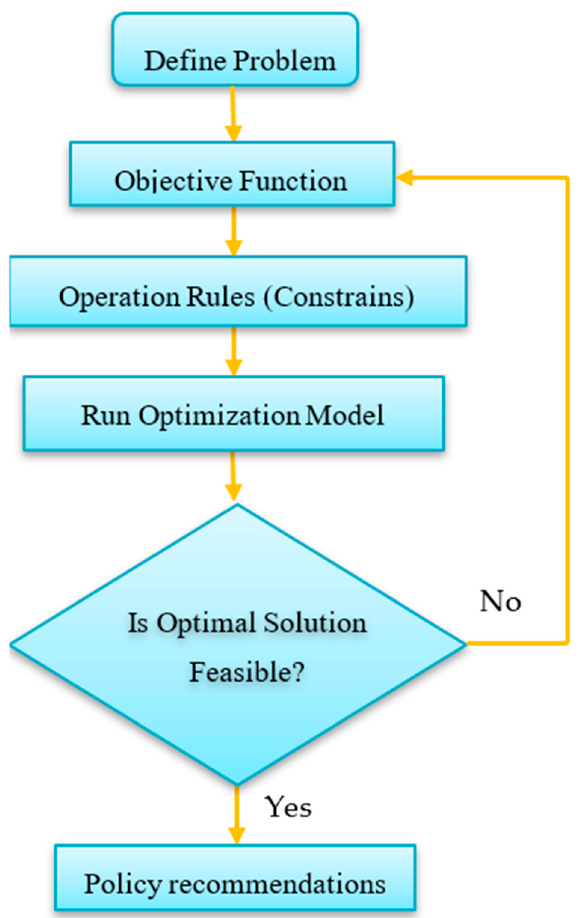
Figure 3. Simplified flowchart for optimization modelling.